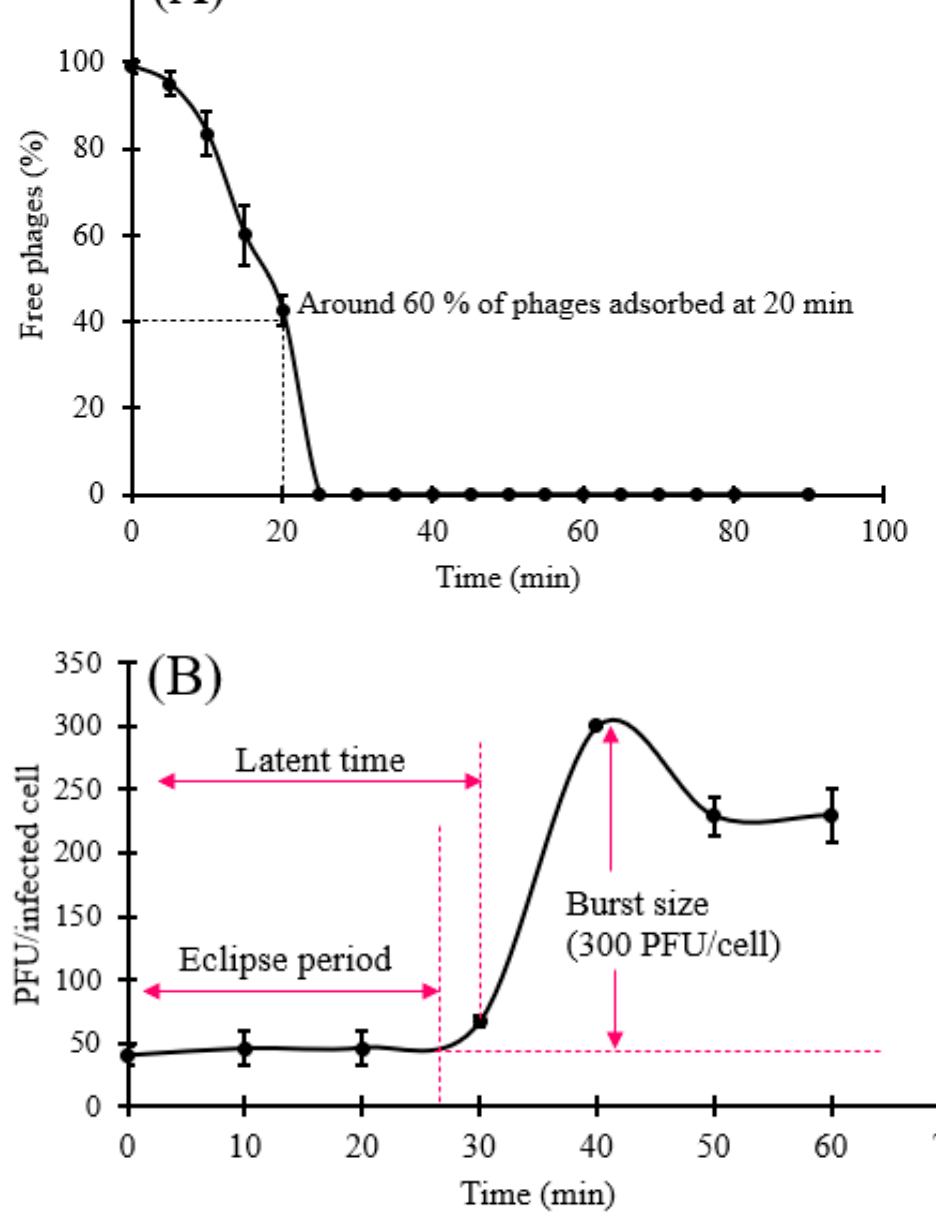
Figure 3. ( A ) Phage adsorption plots of vB_PseuP-SA22. The X -axis represents the time of exposure and Y -axis indicates the percentage of free phage particles found at different time points. ( B ) Three phases of one round lytic cycle of vB_PseuP-SA22. All values represent the mean + SD of triplicated